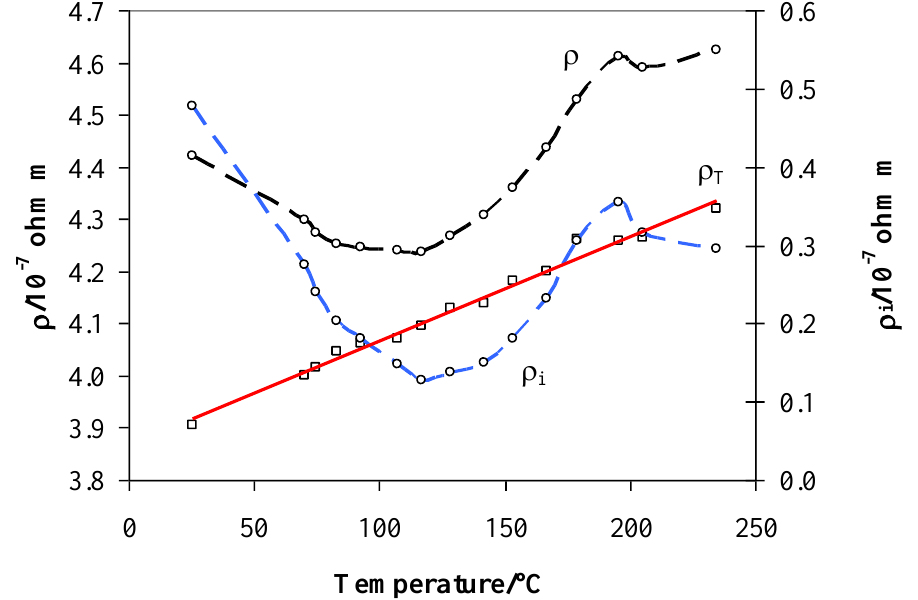
Figure 6. Total resistivity ρ and its contribution due to the scattering ρ i of Pd 79 –Ag 21 foil measured in 100 kPa hydrogen at di ff erent temperatures.